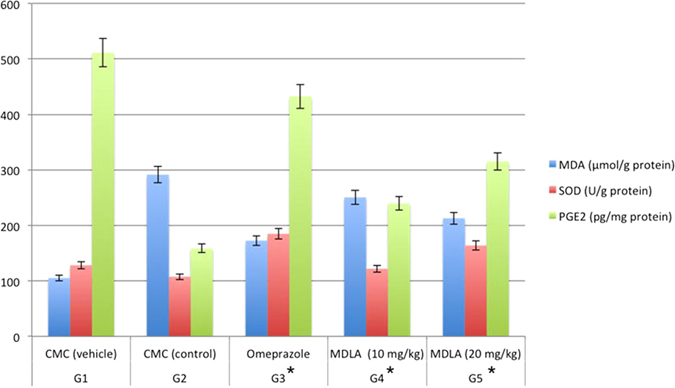
The effect of MDLA on MDA level (μmol/g protein), SOD activity (U/g protein) and PGE2 (pg/mg protein) in gastric mucosal homogenate in rats.MDLA increased the PGE2 and SOD, and decreased the level of lipid peroxidation (MDA) in the pre-treated groups. All values are expressed as mean ± standard error mean, the mean difference is significant at (*p < 0.05) level compared to CMC (Control). Data were analyzed using one way ANOVA using SPSS 18.